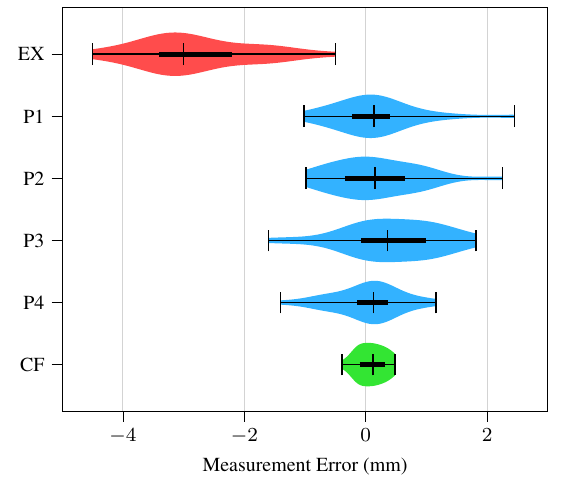
Figure 4. Distributions of measurement differences over participants due to the expert’s use of measuring device (red), 3D image source by the non-experts using Cliniface for manual measurement (blue), and 3D image source by Cliniface using non-rigid registration to derive measurements (green).